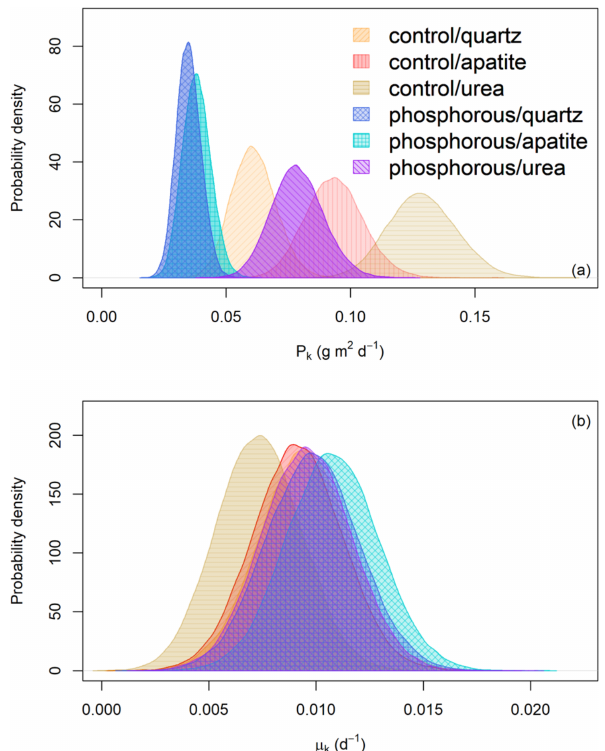
Figure 4. (a) Probability distribution of the predicted EMF biomass production ( P k ) (gm 2 d − 1 ) for the different fertilizer treatments (control and P fertilization) and mesh-bag amendments (quartz- only, apatite and urea). (b) Probability distribution of the turnover rates (d − 1 ) for the different fertilizer treatments (control and P fer- tilization) and mesh-bag amendments (quartz-only, apatite or